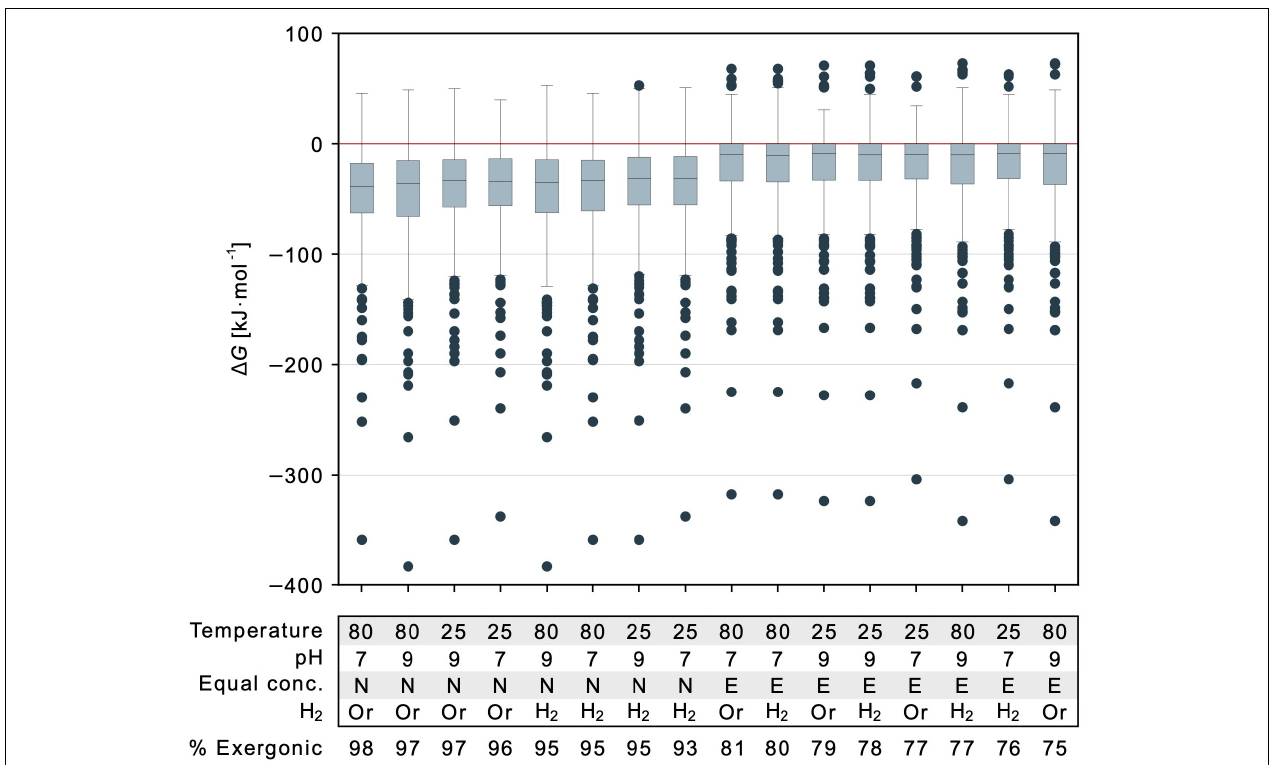
FIGURE 5 | Energetic effect of temperature, pH, reductants and reactant to product concentration ratios. Gibbs energy is indicated for 351 calculable reactions that deliver a value of (cid:49) G for different parameter combinations. Values for each parameter of each calculation are specified in the table below the figure and varied with respect to physiological and vent conditions. Temperature is described in degree Celsius. Equal conc.: E indicates all concentrations set to 1 mM, N indicates nonequilibrium 1:0.01 mM reactant to product ratio. Retention of organic reductants (NADH, NADPH, flavodoxin red , ferredoxin red ) is indicated as Or while the replacement of these organic reductants with hydrogen is marked by H 2 . Note that in this case, two additional reactions yield a value for (cid:49) G (353 reactions). Proportions of exergonic reactions ( (cid:49) G ≤ 0 kJ · mol − 1 ) across the biosynthetic core are listed below the table. In each boxplot, the horizontal line indicates the median (cid:49) G among calculable reactions. The colored boxes represent the interquartile range (IQR) with (cid:49) G within quartile 1 (Q1, median of lower half of the data) and quartile 3 (Q3, median of upper half of the data). The range bars mark the minimum (Q1 – 1.5 · IQR) and maximum (Q3 + 1.5 · IQR) value of the data excluding any outliers. Outliers are indicated by individual dots and do not fall into the defined range between minimum and